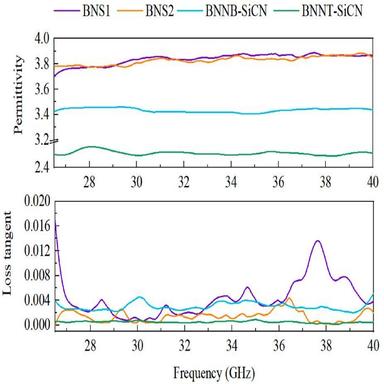
Waveguide readings: Permittivity (ε) and loss tangent (tan δ) of the four samples are shown as a function of frequency (26.5–40 GHz).